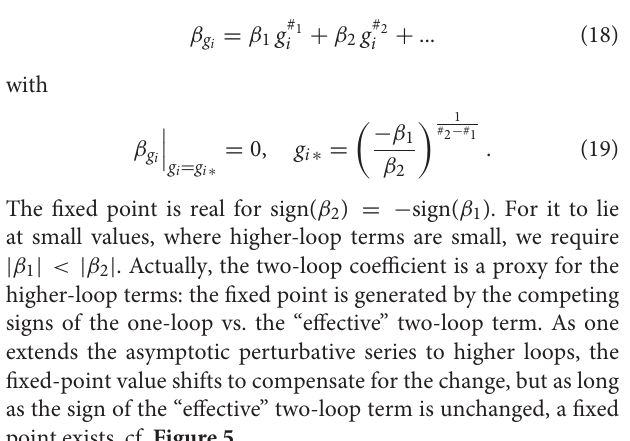
FIGURE 4 | Left upper panel: Based on results in Morris (2005), the beta function for SU(3) Yang-Mills theory in the epsilon expansion for (black line), ǫ 1 at one loop (dotted), two loops (dot-dashed), three loops (dashed) and four loops (green). Right upper panel: Fixed-point value for α as a function = of ǫ up to ǫ (dotted), ǫ 2 (dot-dashed), ǫ 3 (dashed), and ǫ 4 (continuous) emerge from the free fixed point at d g 2 calculation taken from Gies (2003) for α 4 π =